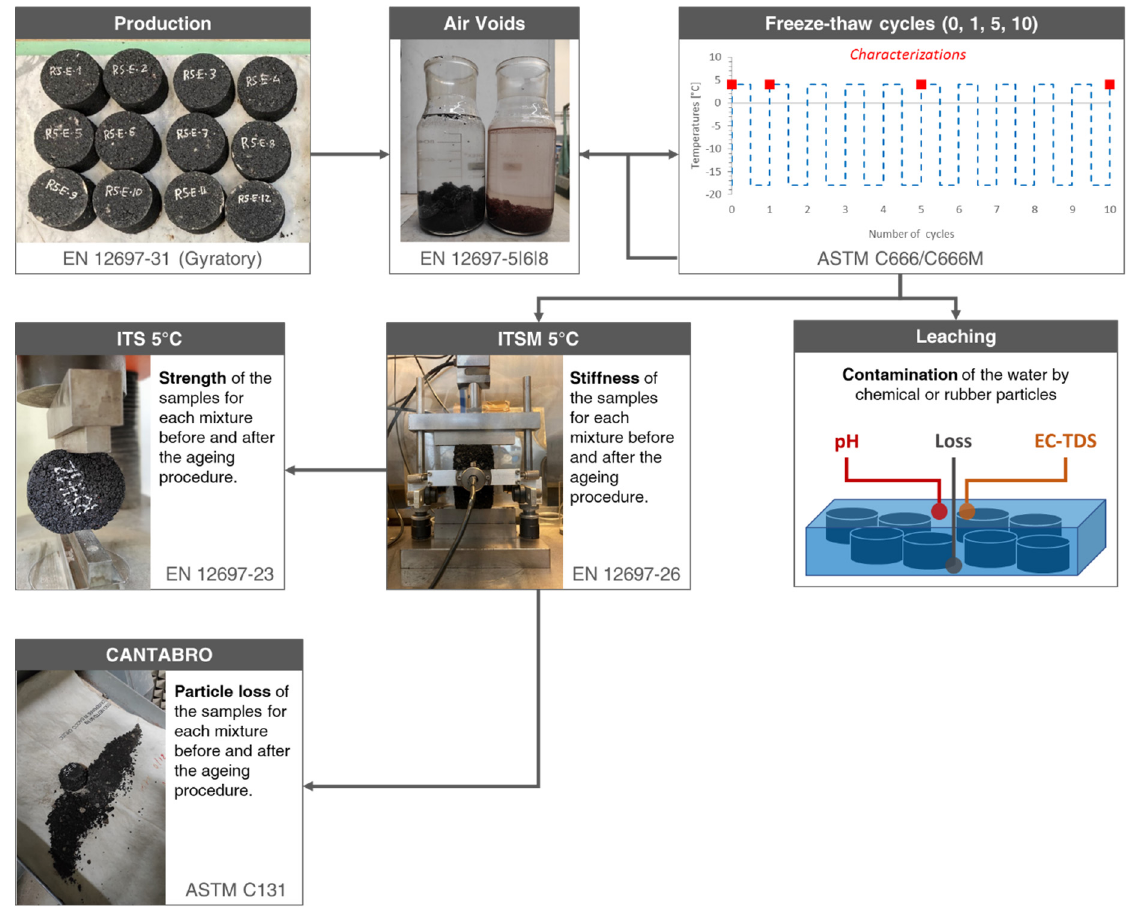
Figure 3. Summary of the experimental programme for each F–T cycle.